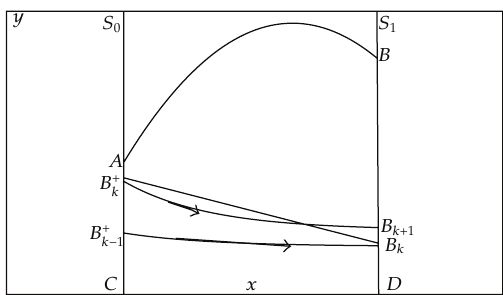
Figure 1: Poincar´e map of system (cid:7) 1.1 (cid:8)